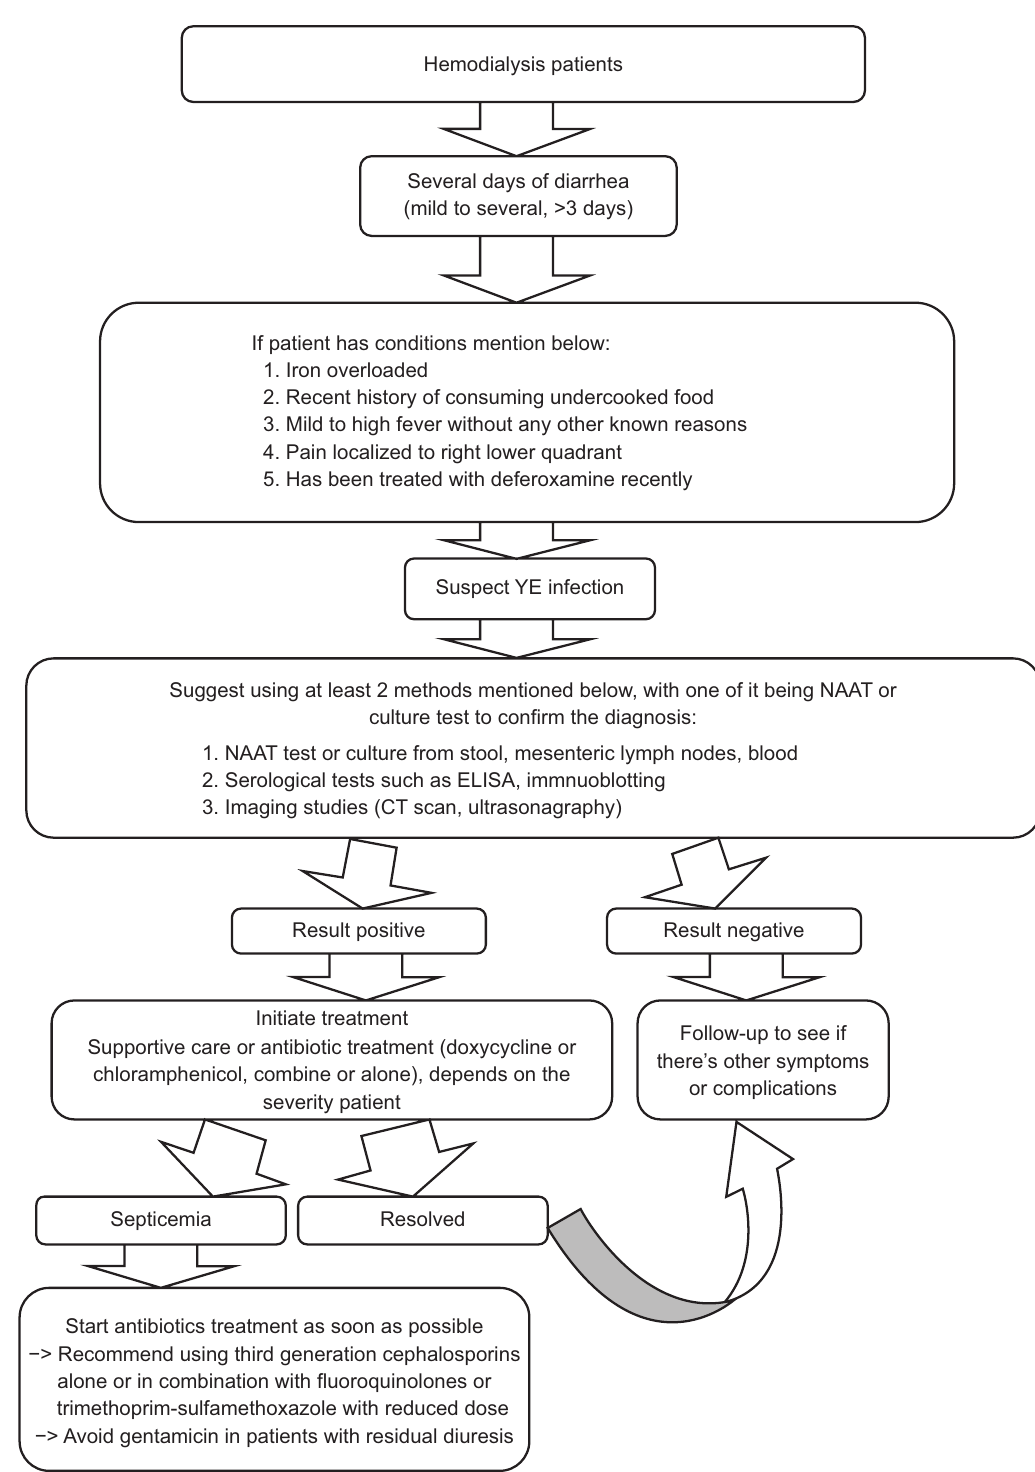
Figure 2: Suggested algorithm for the management of Yersinia enterocolitica infection in hemodialysis patients. YE: Yersinia enterocolitica; NAAT: nucleic acid amplification test; CT: computed tomography; ELISA: enzyme-linked immunosorbent